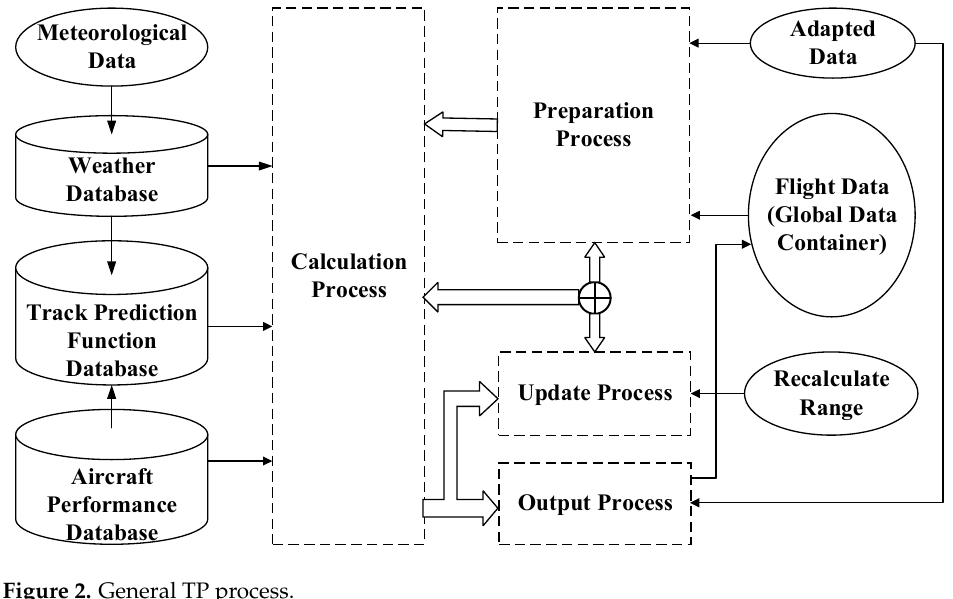
Figure 2. General TP